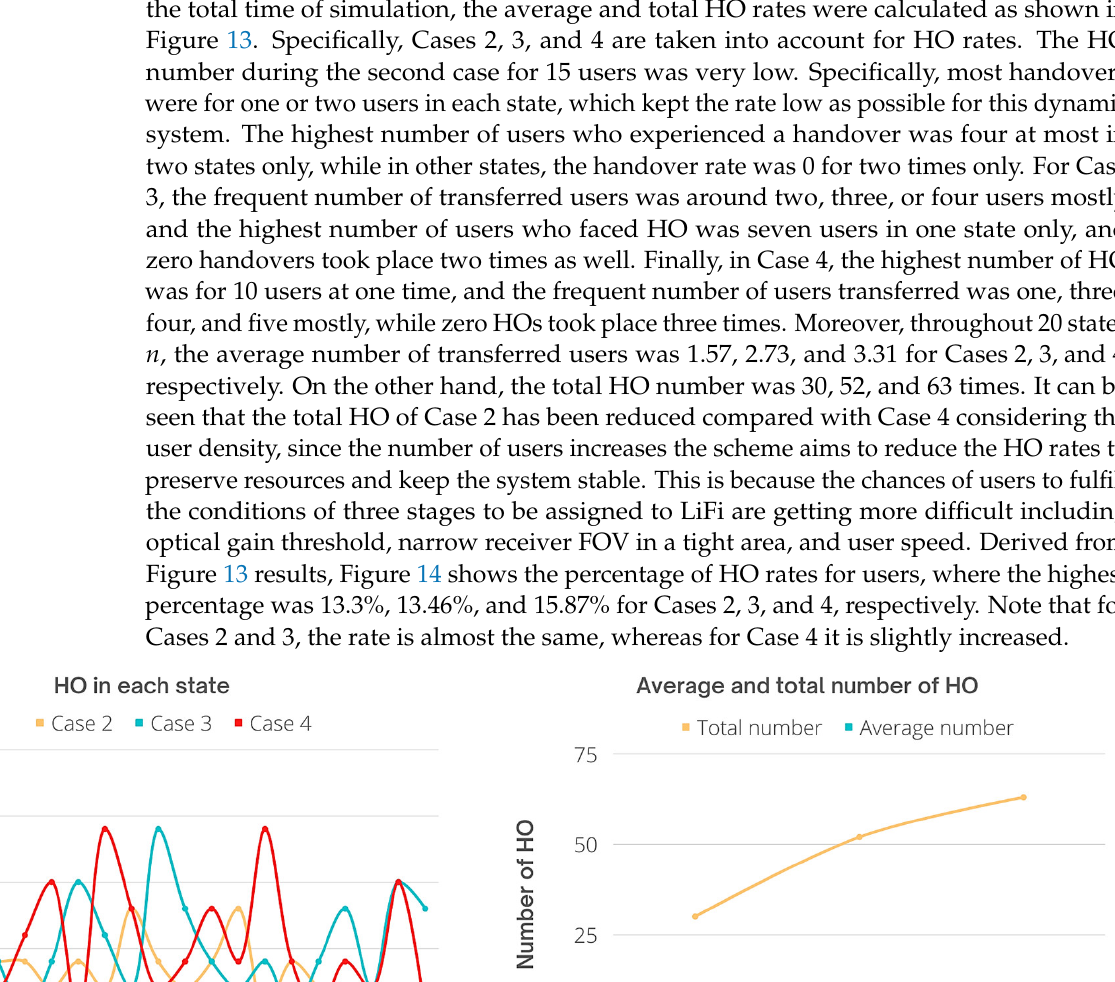
Figure 14. Percentage of HO rates. ( a ) Throughout each state, and ( b ) Total and the average number of each case. Finally, the percentage of the average of all cases was 5.25% for Case 2, 5.25% for Case 3, and 5.25% for Case 4. Eventually, the average percentage for all cases is the same ob- tained by the proposed scheme which aims to not only prevent unnecessary handovers that could degrade the performance of the network but to reduce the overall HO rates based on the user data rate requirements and HO overhead. 4. Conclusions A novel three-phase handover management and access point transition TPHM-APT was designed and developed in this study that aims to control and reduce HO rates for connected users in addition to access point assignment and load balancing in the hybrid LiFi/WiFi network. This research focuses on APA and HO problems with consideration of user mobility and user density. Former research used SINR, average data rate, RSS, user velocity, and/or optical gain, whereas the scheme in this research aims to use a combina- tion of factors in addition to receiver FOV and angle of incidence to make decisions for HO process and APA that is used to allocate a user to either a LiFi or WiFi APs. The goal of this process would decrease the load on the LiFi resources and increase system stability. The performance analysis of the proposed scheme was carried out using Monte Carlo simulations and mathematical analysis. Four cases were taken into consideration, each